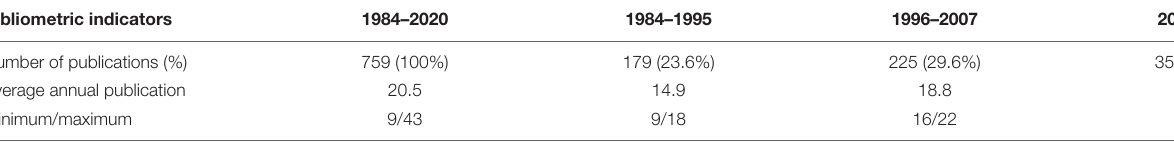
TABLE 1 | Publication quantity stratified by period.